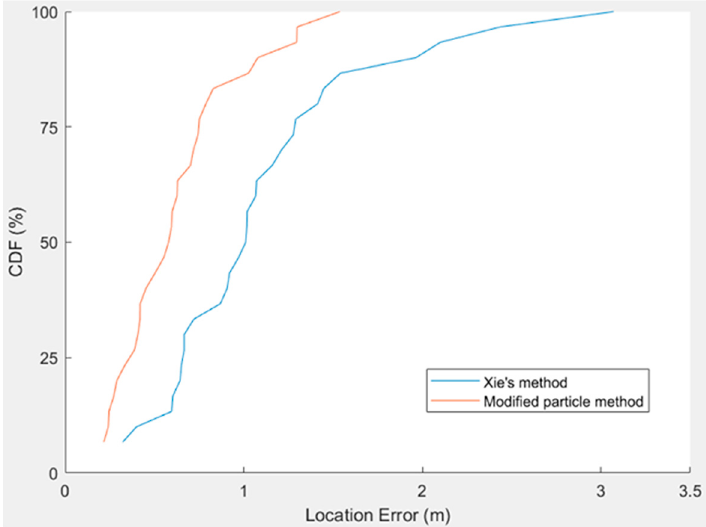
Figure 12. Cumulative distribution function illustration of the location error for Xie’s method and the modified particle method.